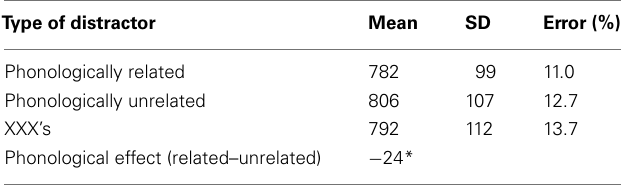
Table 1 | Experiment 1. Mean RTs (ms), SD, and percentage of errors (Error %), for phonologically related, unrelated, and baseline conditions.